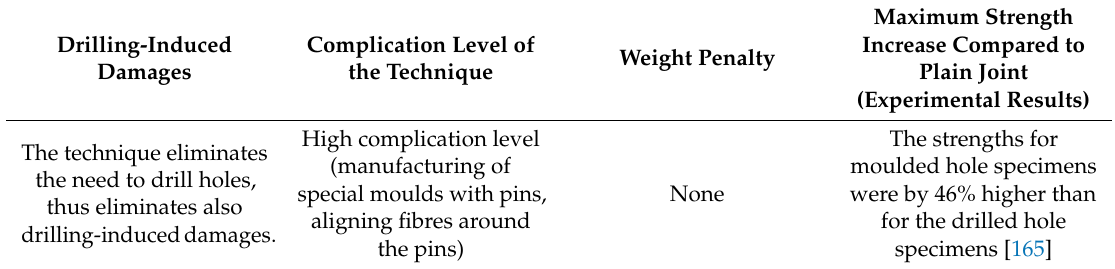
Table 5. Summary of moulded holes e ff ect on performance of bolted joints in composite